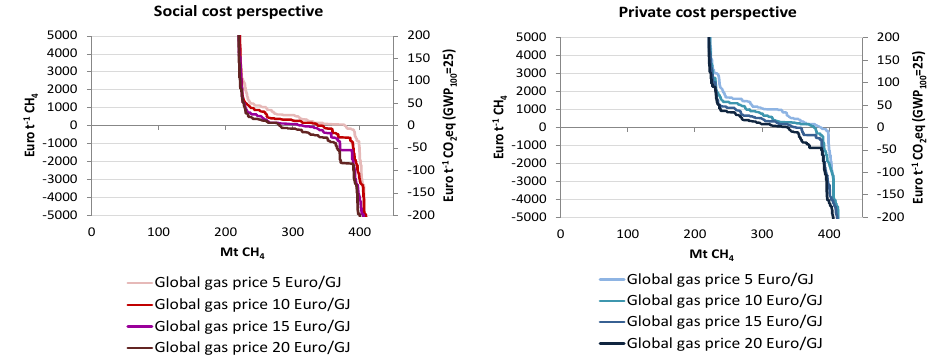
Fig. 11. Sensitivity of the global marginal mitigation cost curve in 2030 to different assumptions about the future gas price